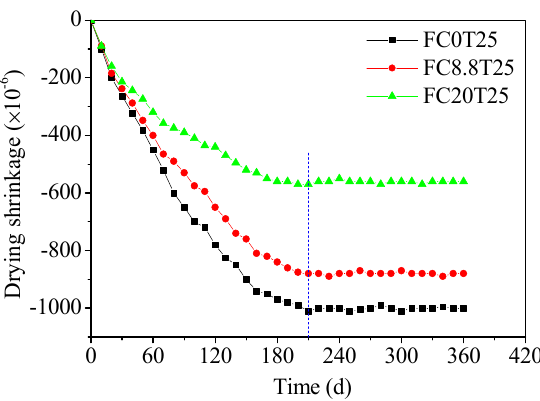
Figure 8. Evolution of drying shrinkage of CS − FA − GEO composites for FC0T25, FC8.8T25, and FC20T25 of up to 360 d.